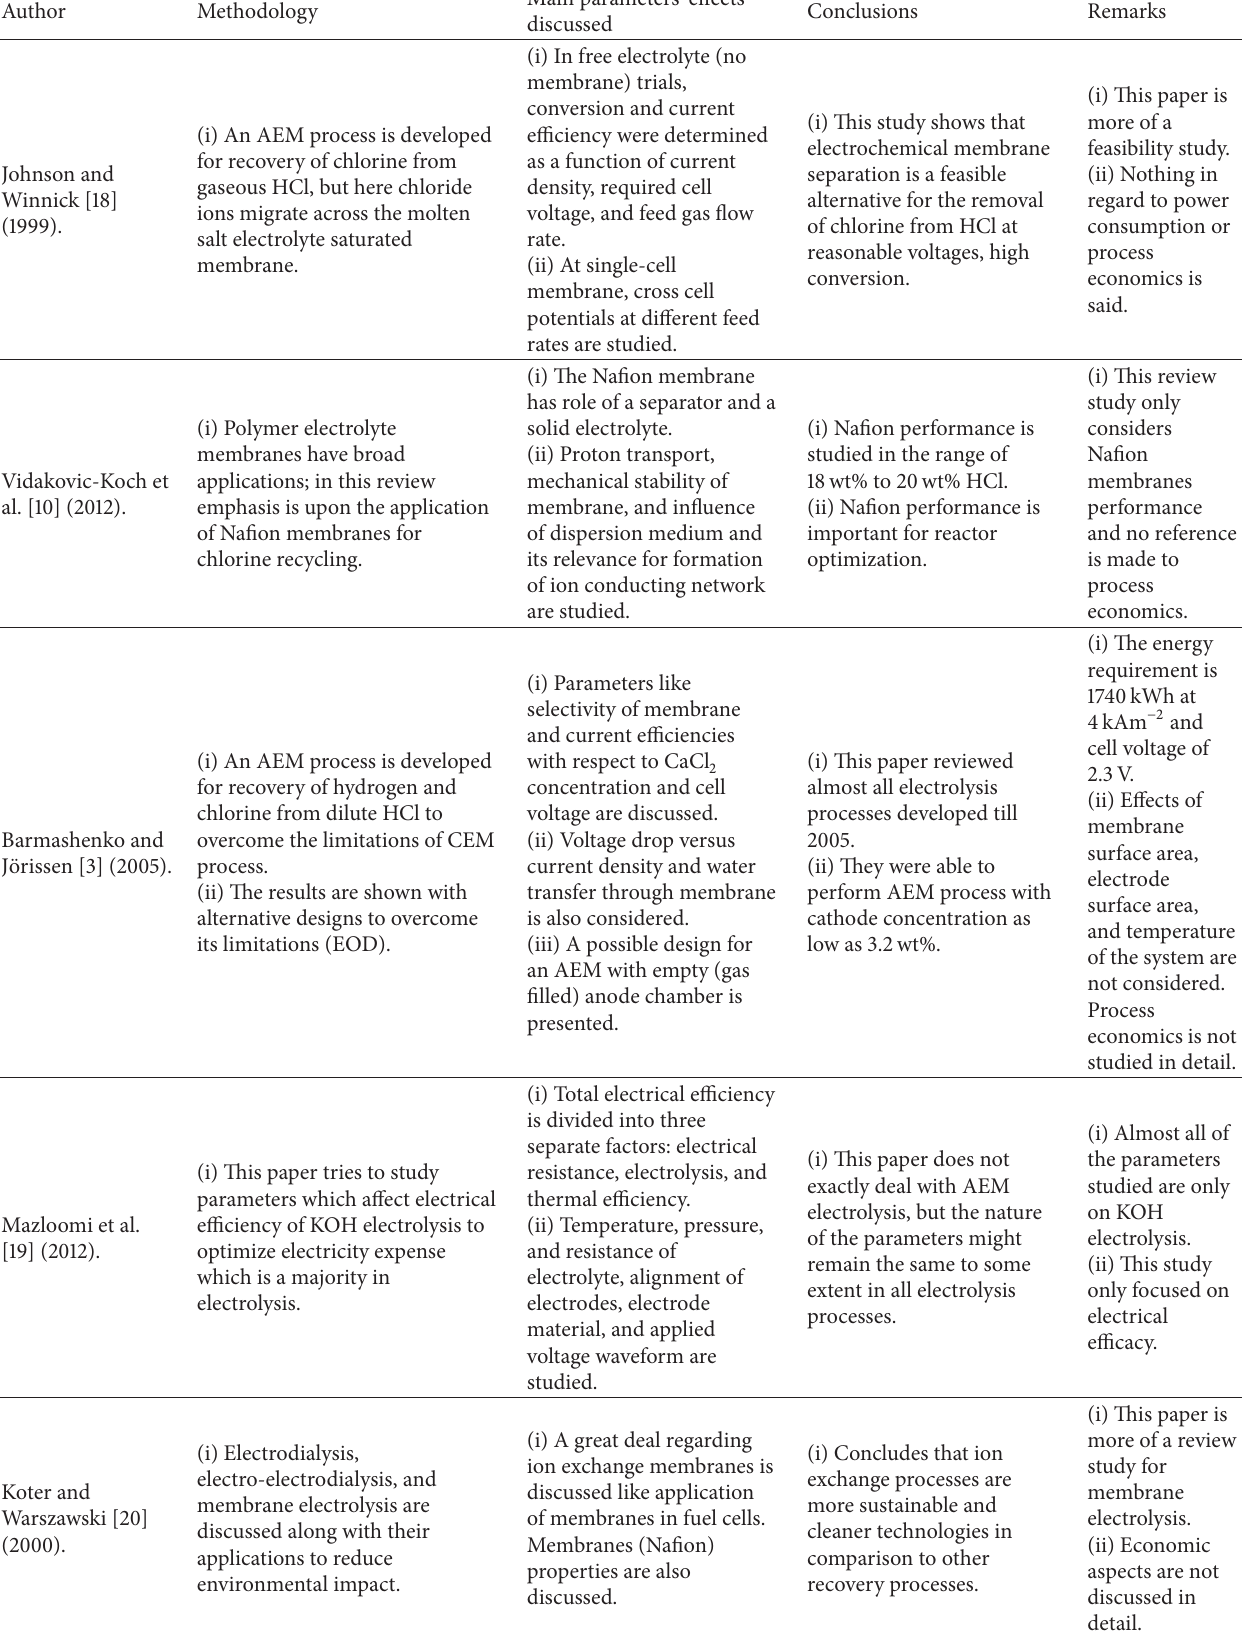
Table 2: Research studies on chlorine